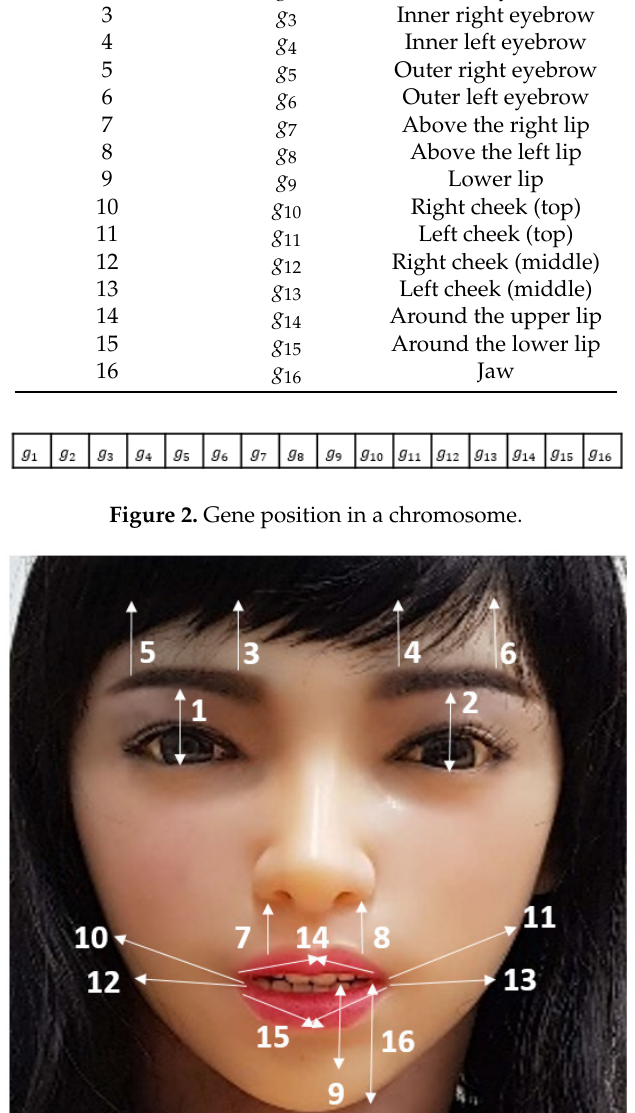
Figure 3. Face control positions of